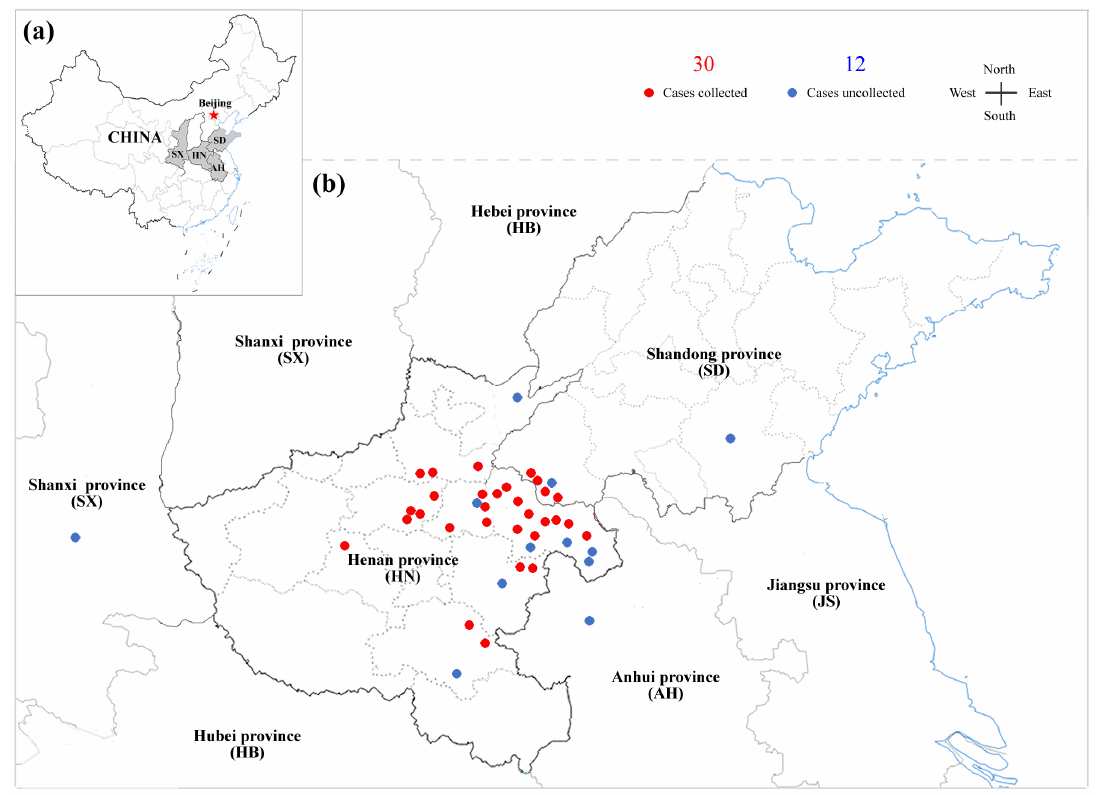
Figure 1. Distribution of poultry farms with neoplastic disease cases in chicken flocks selected from central China during 2020–2022. ( a ) Geographic location of central provinces in China. ( b ) Poultry farms with case reports in central China. All of the cases selected, sampled (2020–2021) or unsampled (2022), are shown by red and blue spots, respectively.